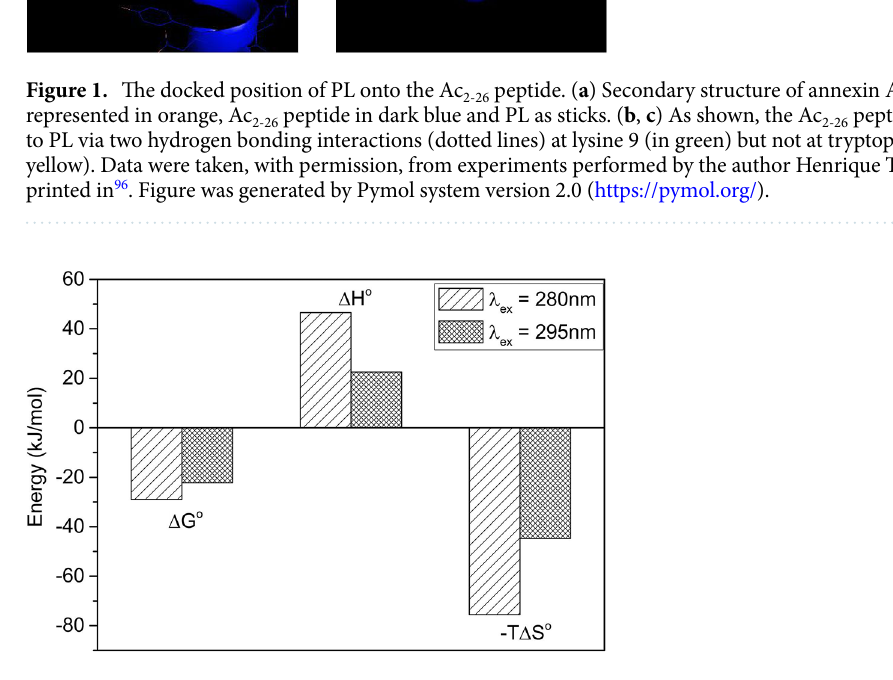
energy variation was negative (ΔG < 0), as shown in Fig. 2, suggesting that the interaction of PL with the annexin A1-derived peptide Ac 2-26 occurs spontaneously (Supplementary Table S3). For more details, see Supplementary Information and references 46–48 .